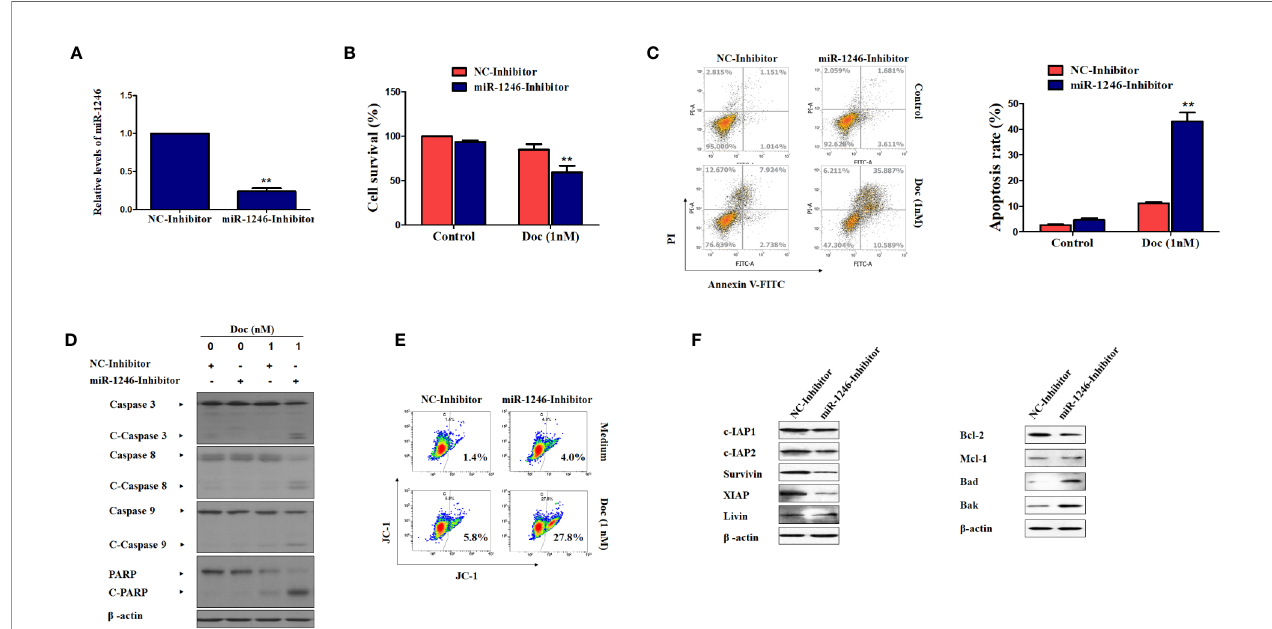
FIGURE 2 | miR-1246 inhibition effectively increase the sensitivity of MDA-MB-231 cells to docetaxel by inducing apoptosis. (A) MDA-MB-231 cells were transfected with speci fi c inhibitor against miR-1246 or negative control (NC) and the silence ef fi ciency was con fi rmed by RT-PCR. (B) The cytotoxicity of 1nM DOC in MDA-MBA-231 cells transfected with miR-1246 inhibitor or NC were determined by MTT assay. (C) After transfection of miR-1246 inhibitor or NC, Doc induced apoptosis in MDA-MB-231 cells were detected by fl ow cytometry. (D) The cleavage of caspase 3, 8, 9 and PARP were also determined by western blotting in MDA- MB-231 cells treated with Doc in combination with miR-1246 inhibitor or NC. (E) The mitochondrial membrane permeability was tested by fl ow cytometry after JC-1 staining in cells from (D) . (F) The IAPs and Bcl-2 family members expression was determined by western blot assay in MDA-MB-231 cells transfected with miR-1246 inhibitor or NC. Data are presented as mean ± SD, n=3. **P < 0.01 vs.